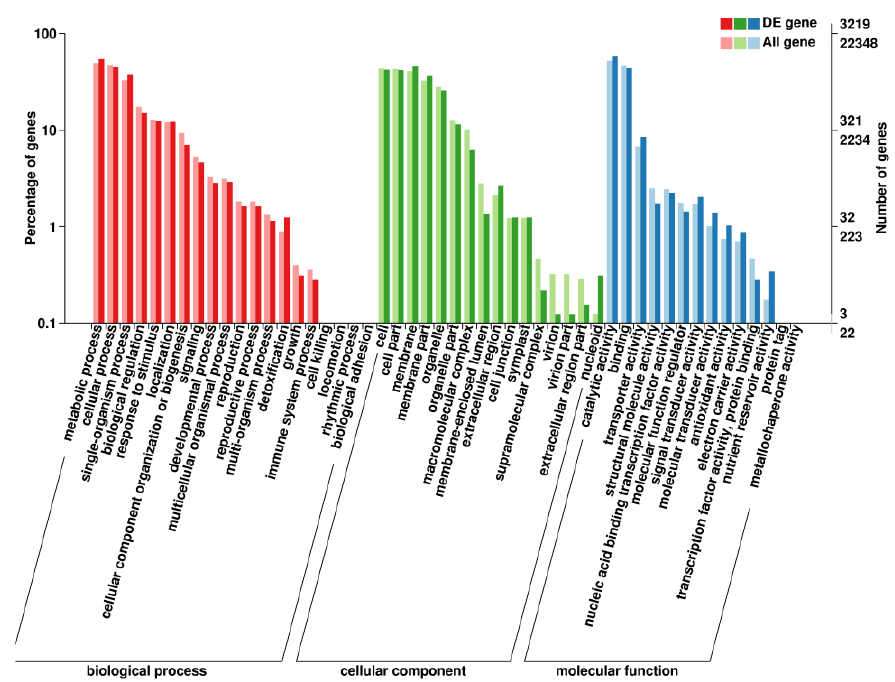
Figure 3. Results of GO enrichment. The percentage of genes assigned to partial subclassifications is shown. Red, green and blue columns represent the biological, cellular, and molecular functions, respectively.